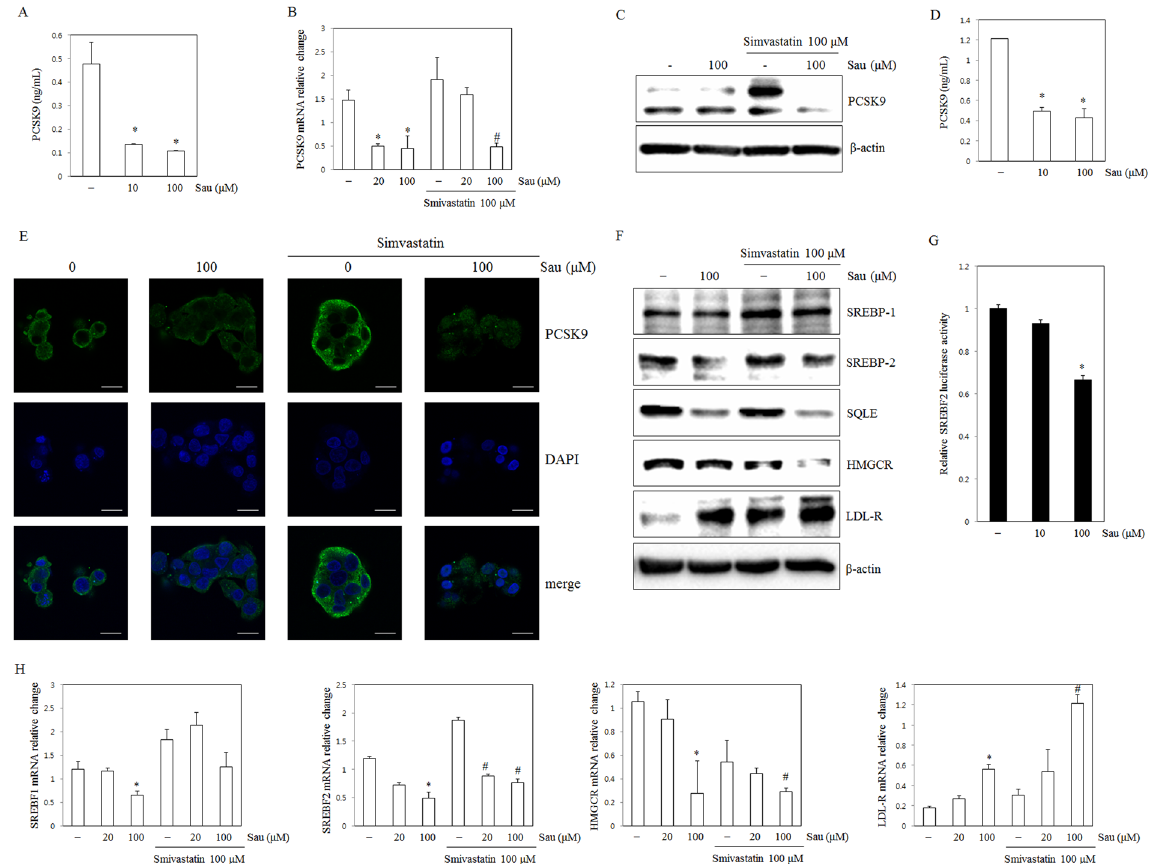
Figure 4. Effect of sauchinone on PCSK9 inhibition in the HepG2 human hepatocellular liver carcinoma cell line. ( A ) The expression of PCSK9 was assayed by ELISA in HepG2 cells treated with sauchinone (10, and 100 μ M) for 24 hours. ( B ) The mRNA expression of PCSK9 was assayed by qRT-PCR in cells treated with sauchinone (20, and 100 μ M), and simvastatin (100 μ M) for 24 hours. ( C ) The protein expression of PCSK9 was assayed by Western blotting in cells treated with sauchinone (100 μ M) and simvastatin (100 μ M) for 24 hours. ( D ) The expression of PCSK9 was assayed by ELISA in mouse primary hepatocytes treated with sauchinone (10, and 100 μ M) for 24 hours. ( E ) Expression of PCSK9 by sauchinone. Cells were cultured for 24 hours, fixed, permeabilized, and incubated with a rabbit monoclonal anti- PCSK9 antibody followed by an Alexa 488 conjugated anti-rabbit IgG (green). The nuclei of the corresponding cells were visualized by 4 ′ ,6-diamidino- 2-phenylindole (DAPI) staining (blue). ( F ) The protein expression of SREBP1 SREBP2, SQLE, HMGCR, LDL-R and β -actin was assayed by Western blotting in cells treated with sauchinone for 12 hours. ( G ) SREBP2 luciferase activity. The relative luciferase activity was measured in HepG2 cells that had been treated with sauchinone (10, and 100 μ M) for 24 hours after transfection with the SREBF2-luciferase construct. ( H ) The mRNA expression of SREBF1, SREBF2, HMGCR and LDL-R were assayed by qRT-PCR in cells treated with sauchinone (20, and 100 μ M) and simvastatin (100 μ M) for 24 hours. Sau: sauchinone. Statistical significance of the differences between each treatment group and the normal group ( * p < 0.05) or the simvastatin- treated groups ( # p < 0.05) was determined. Sau, sauchinone (magnification: × 60, scale bars: 20 µ